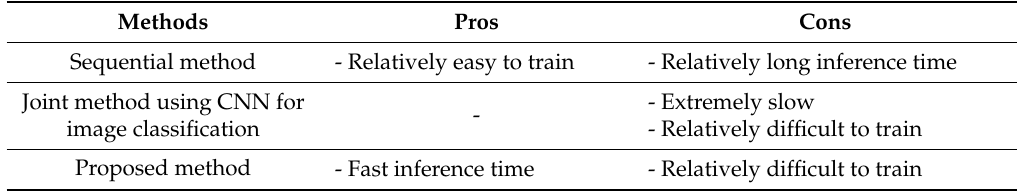
Table 1. A summary comparison for pros and